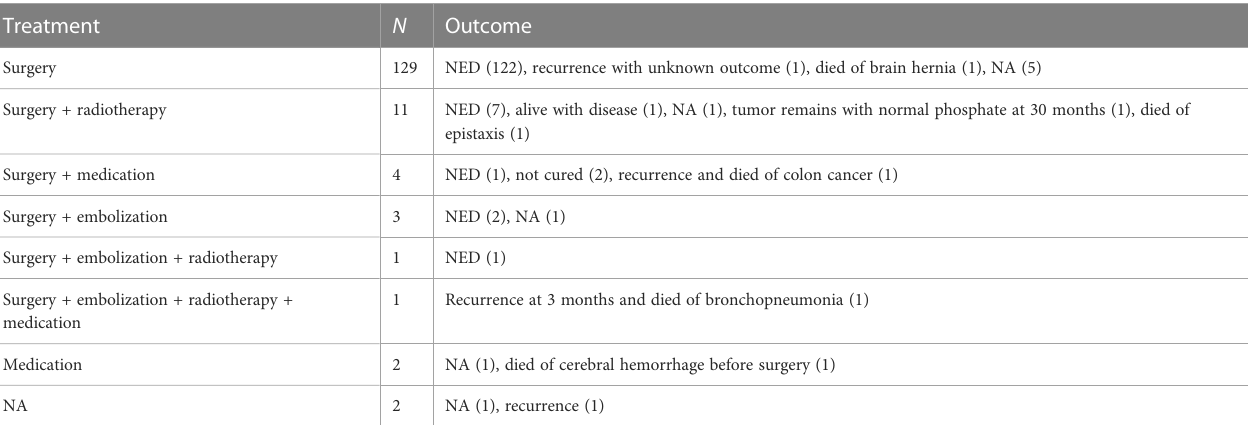
TABLE 3 Summary of the treatment and outcomes of the 153